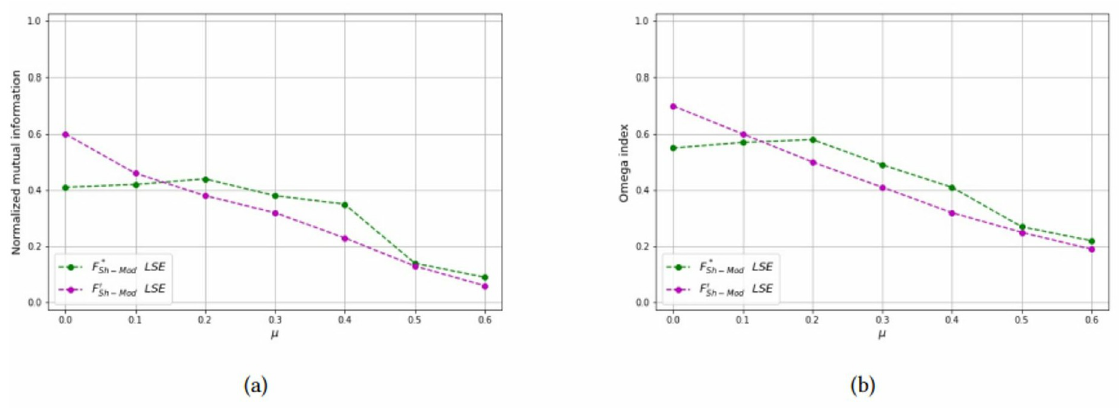
Fig 23. Test results on overlapping communities, parameters N = 1000, n solution method, (b) Average Omega for each solution method.